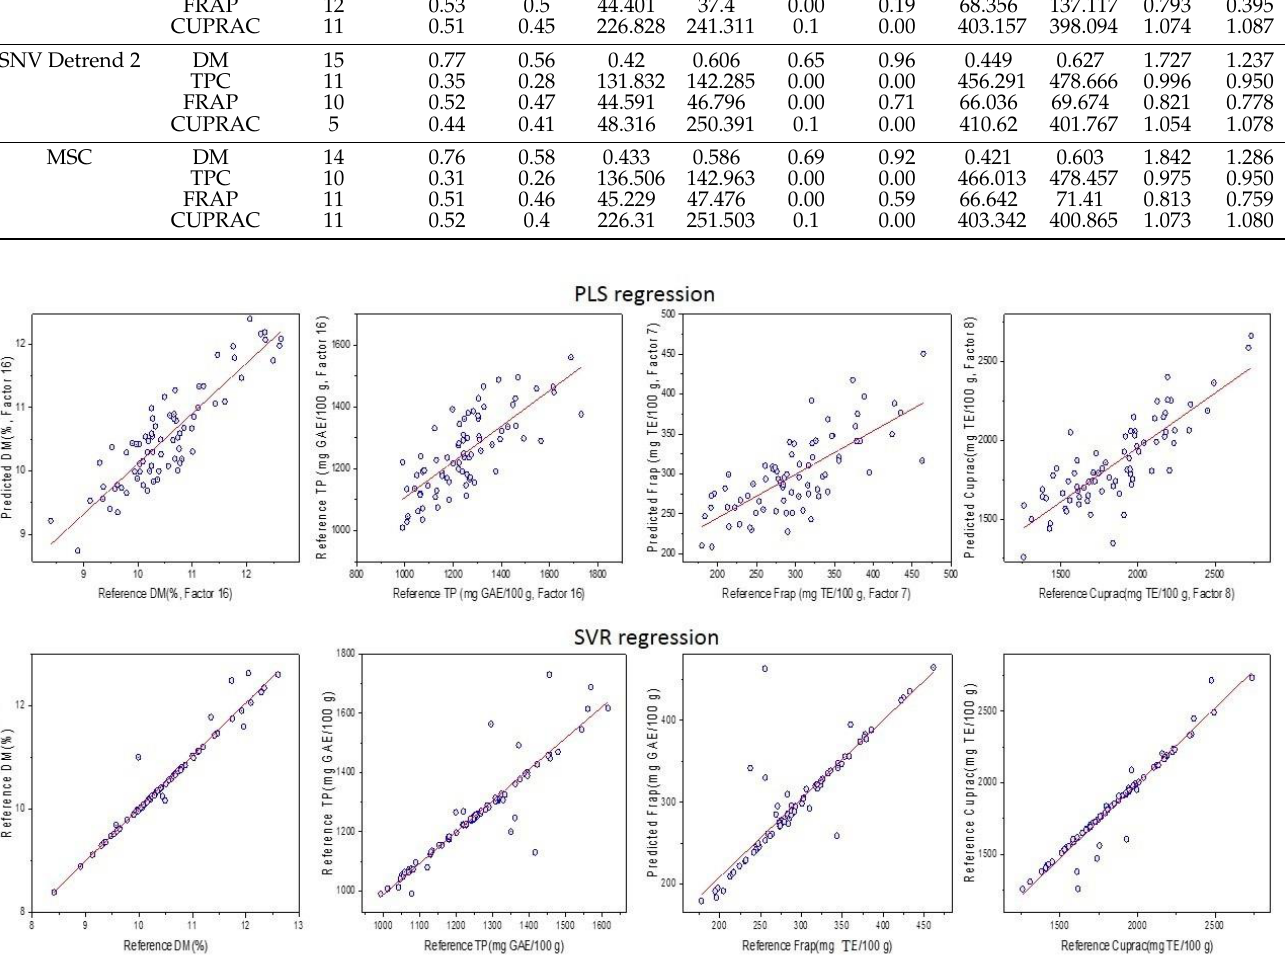
Figure 3. Predicted vs. reference results for the application of NIR spectroscopy for the prediction of dry matter, TPC, FRAP, and CUPRAC contents. Table 3. Statistical parameters were obtained from the application of the PLSR and SVR algorithms on the NIR spectra dataset using different pre-processing methods.